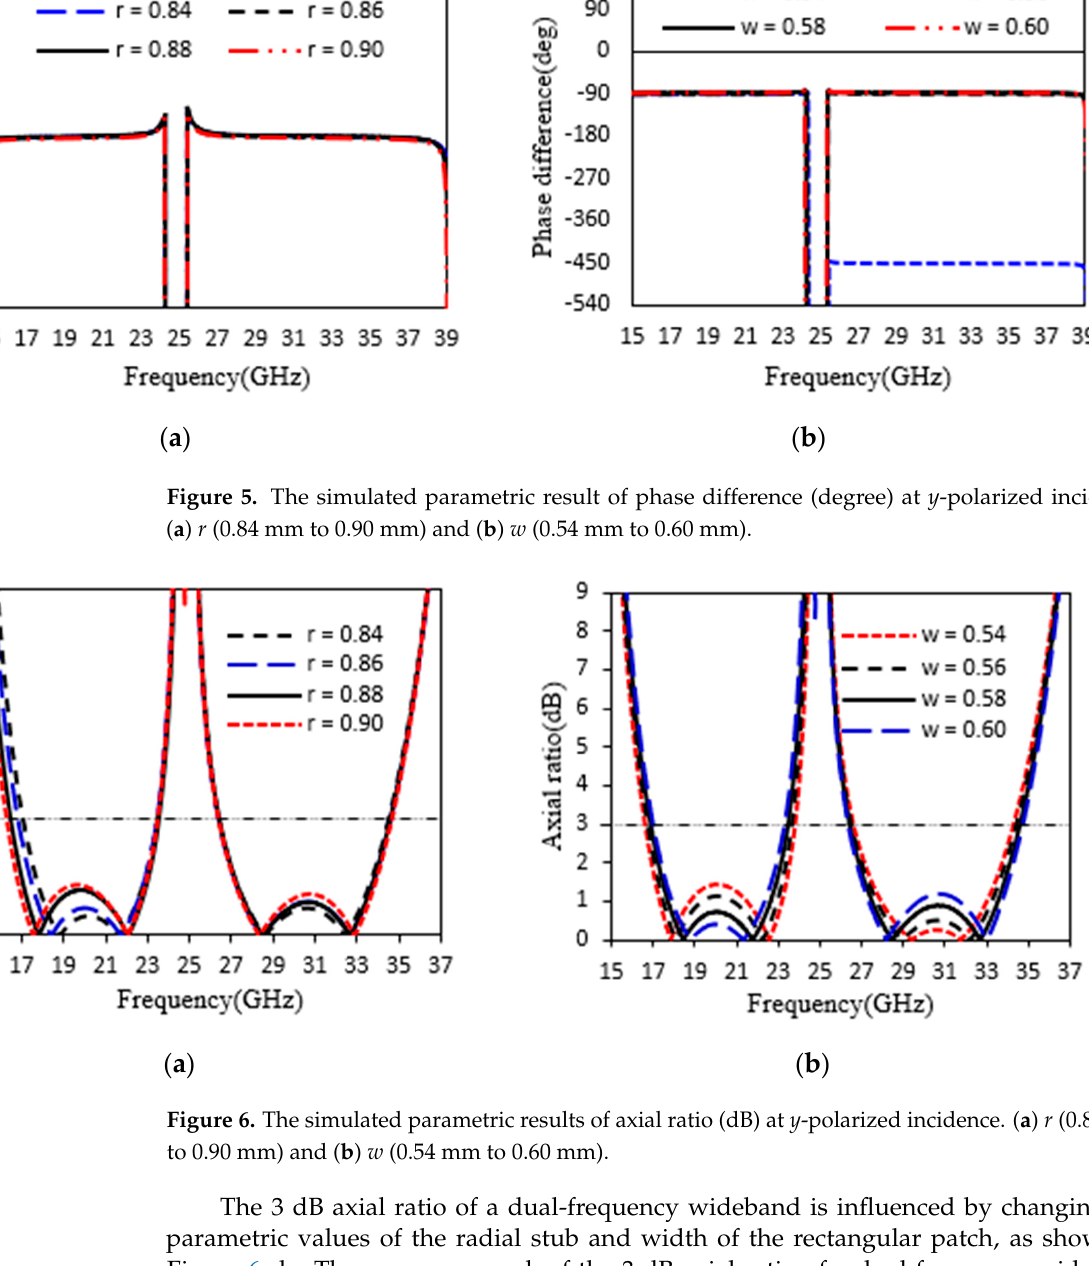
Figure 5. The simulated parametric result of phase difference (degree) at y -polarized incidence. ( a ) r (0.84 mm to 0.90 mm) and ( b ) w (0.54 mm to 0.60 mm).